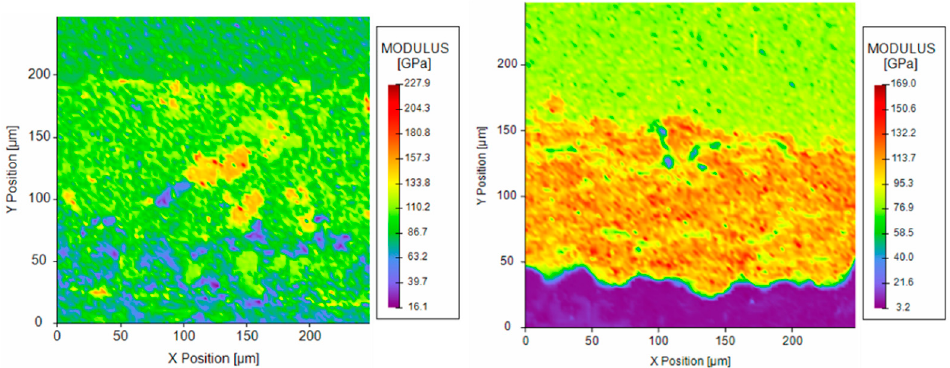
Figure 46. ( Left ) Resultant contour plot of the elastic modulus relative to an indentation grid array